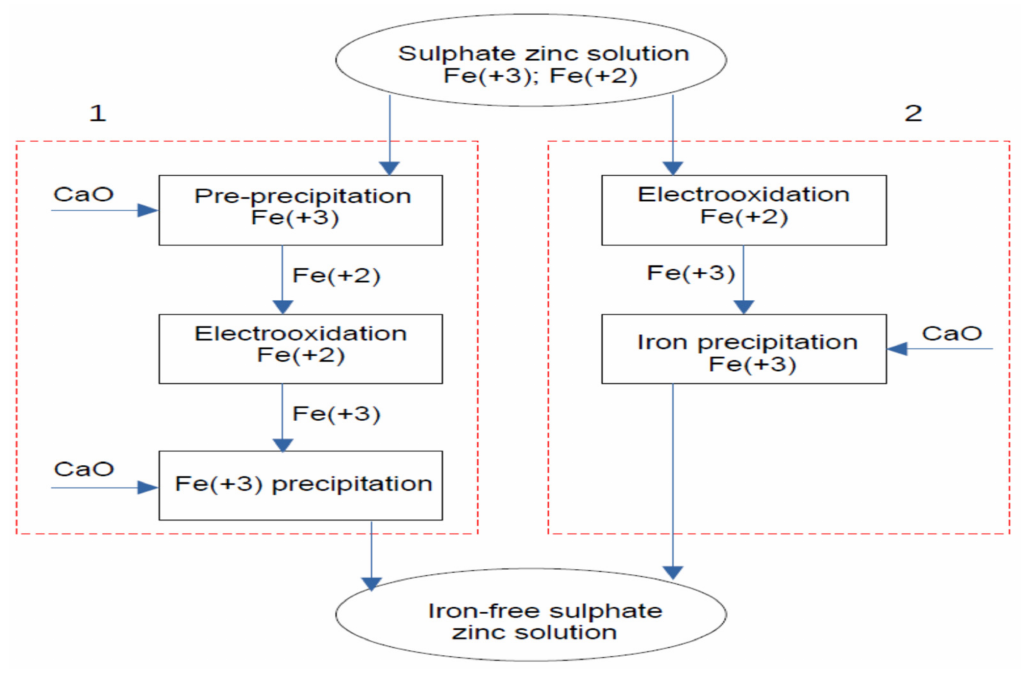
Figure 1. Scheme of the